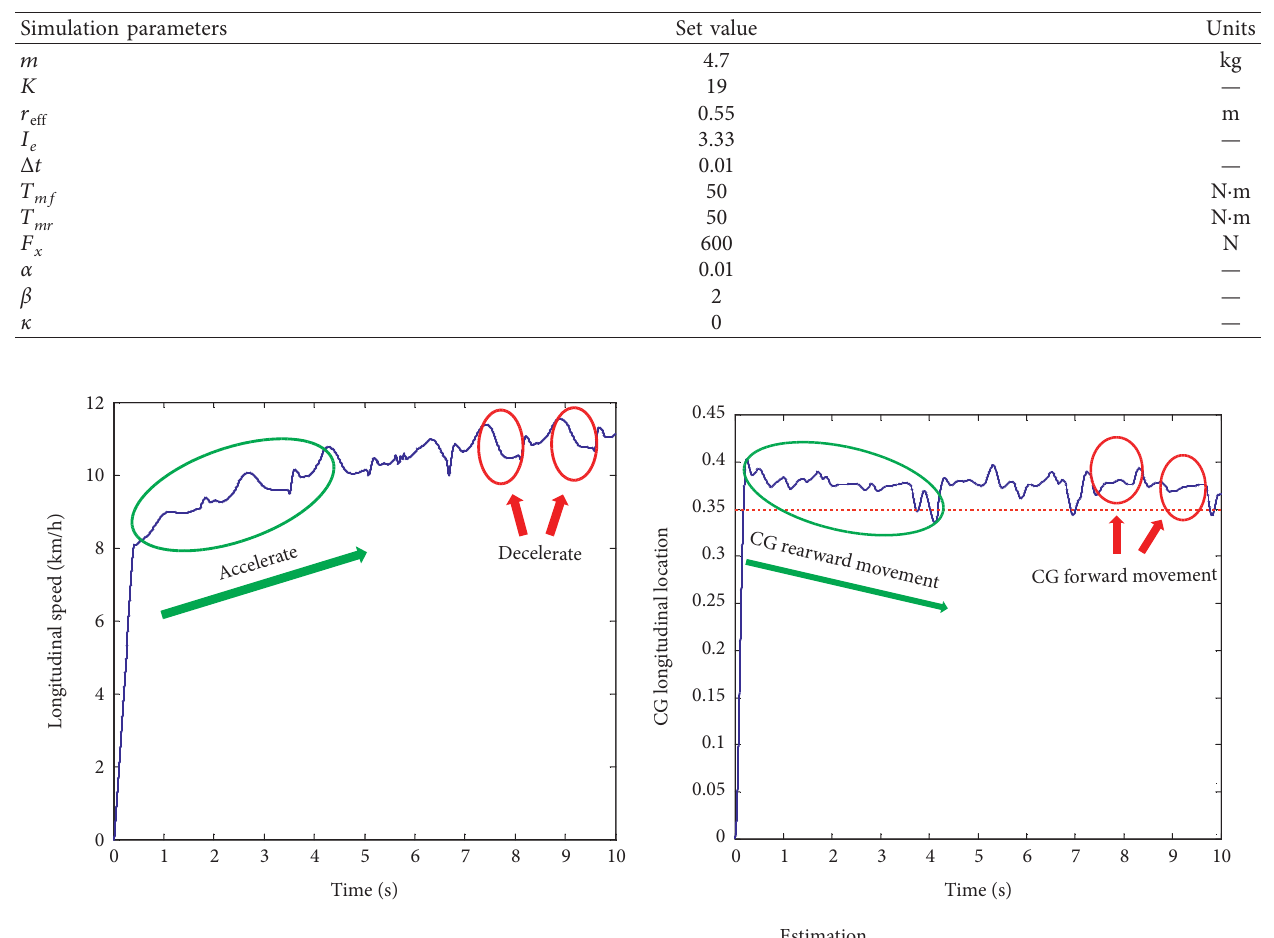
Table 1: Set values of simulation